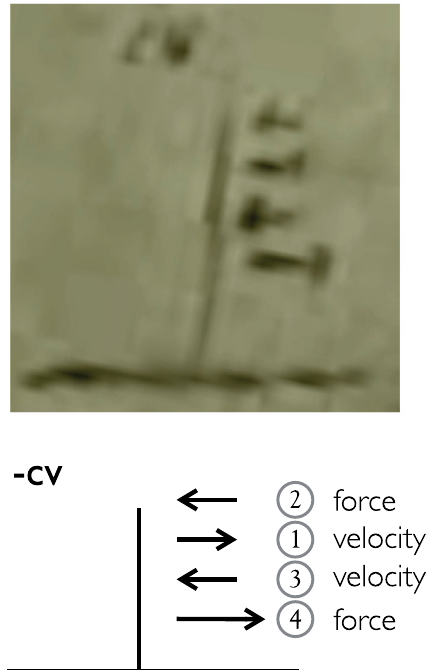
FIG. 5. Top: Bill ’ s diagram that he draws during this segment. Bottom: Our sketch of Bill ’ s diagram, shown to compensate for the poor picture quality of the original. Bill names the arrows as he draws them (numbers 1 – 4 on our sketch): velocity, force, velocity,